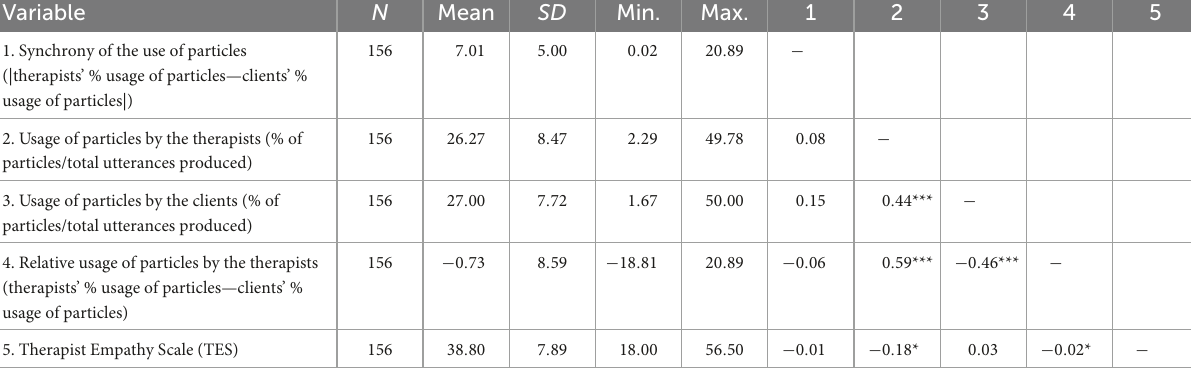
TABLE 1 Session-level mean, standard deviation, range, and intercorrelations of study variables. Variable